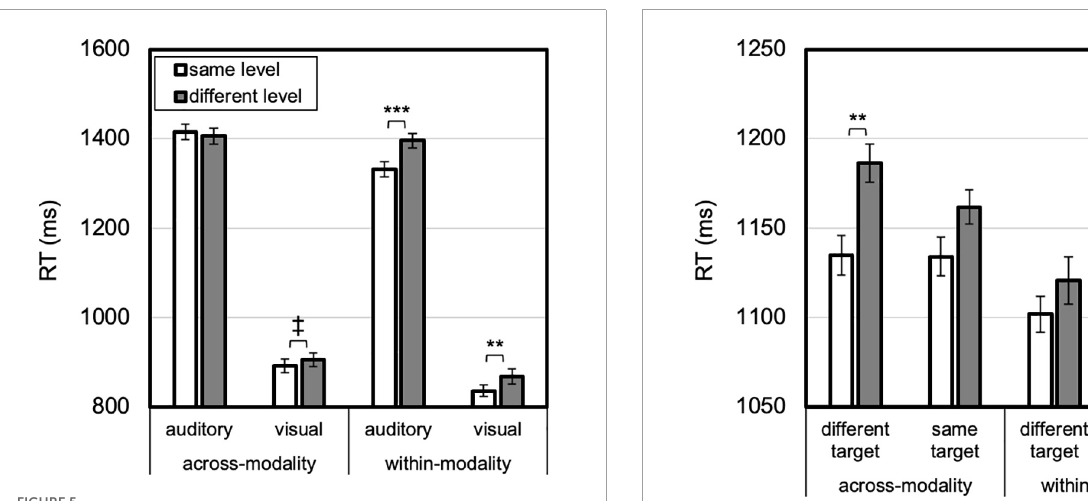
FIGURE5 Modality by modality priming by level priming. A within-modality same-level benefit (vs. different-level) was greater for auditory than visual targets. A trend for a visual across-modality same-level benefit was present. Error bars reflect SE s adjusted for within-subjects